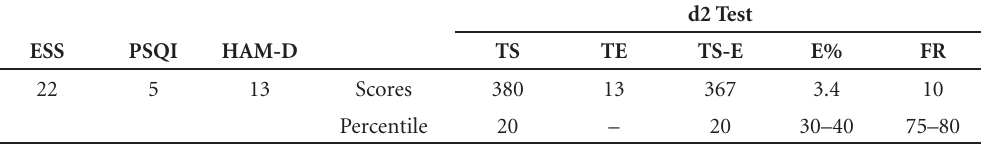
Table 2. Raw and scaled scores of subject 2 on the ESS, PSQI, HAM-D scales and